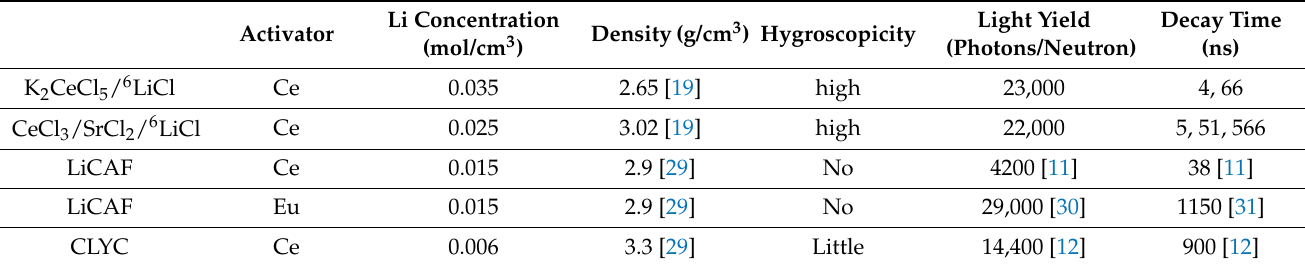
Figure 8. Decay curves of prepared ( a ) K 2 CeCl 5 /LiCl and ( b ) CeCl 3 /SrCl 2 /LiCl under 252 Cf irradiation. Table 1. Scintillation properties of the prepared eutectics and common thermal neutron